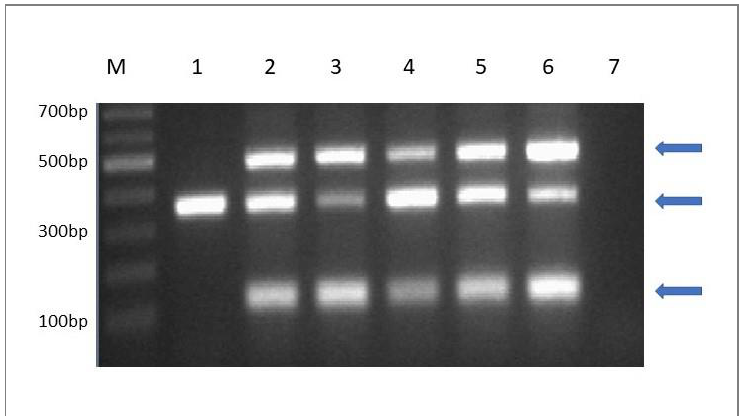
Figure 5. Molecular identification of L. paracasei K5 at levels ≥ 6 log cfu/g in Feta -type cheese after 90 th day of production by strain-specific multiplex PCR assay (M: DNA ladder, Lane 1: C1 control cheese, Lane 2: C2 cheese, Lane 3: C3 cheese, Lane 4: C4 cheese Lane 5: C5 cheese, Lane 6: pure culture of Lb. paracasei K5 and Lane 7: negative control).